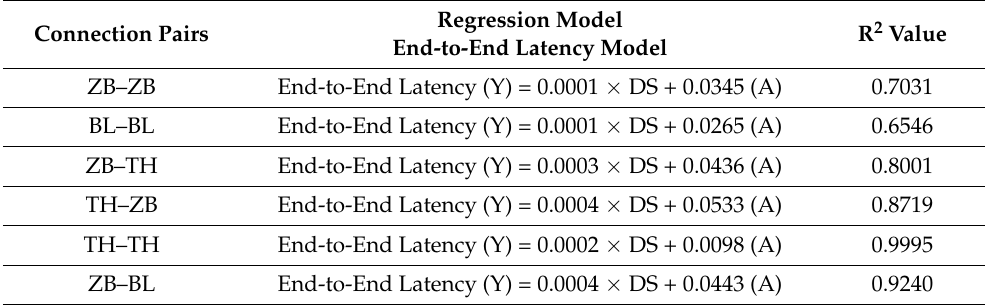
Table 4. Univariate Regression Models Built Based on End-to-End Latency Experimental Outcomes.